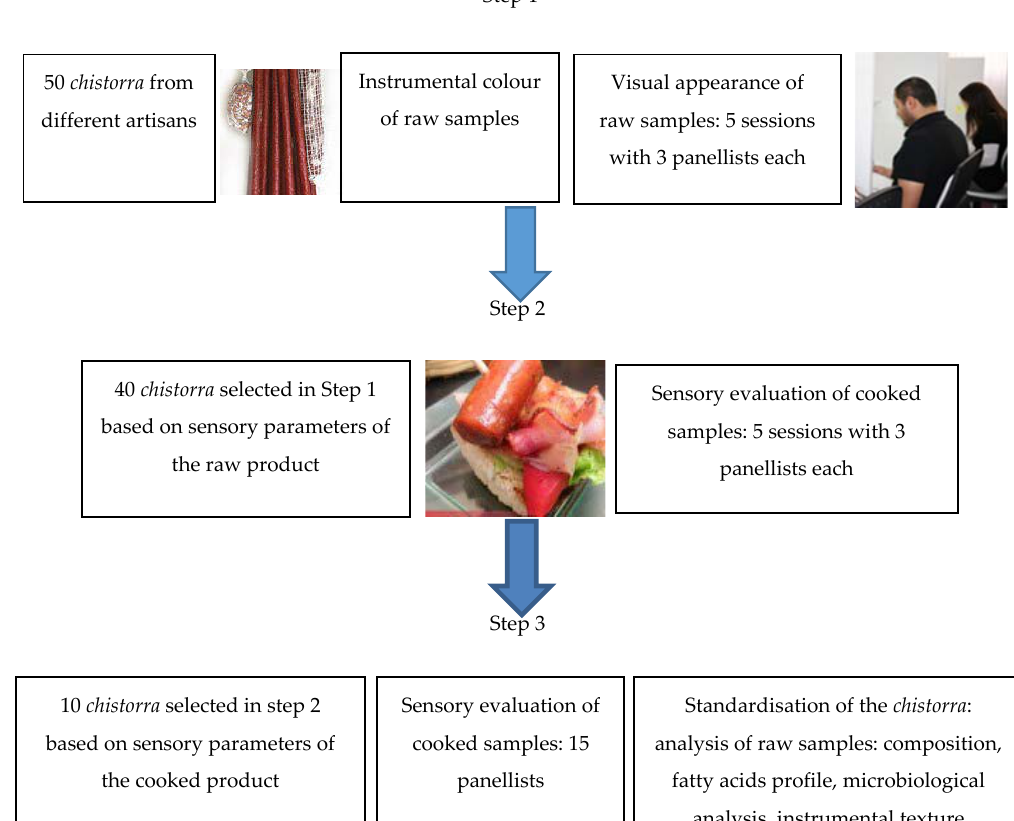
Figure 1. chistorra selection methodology.